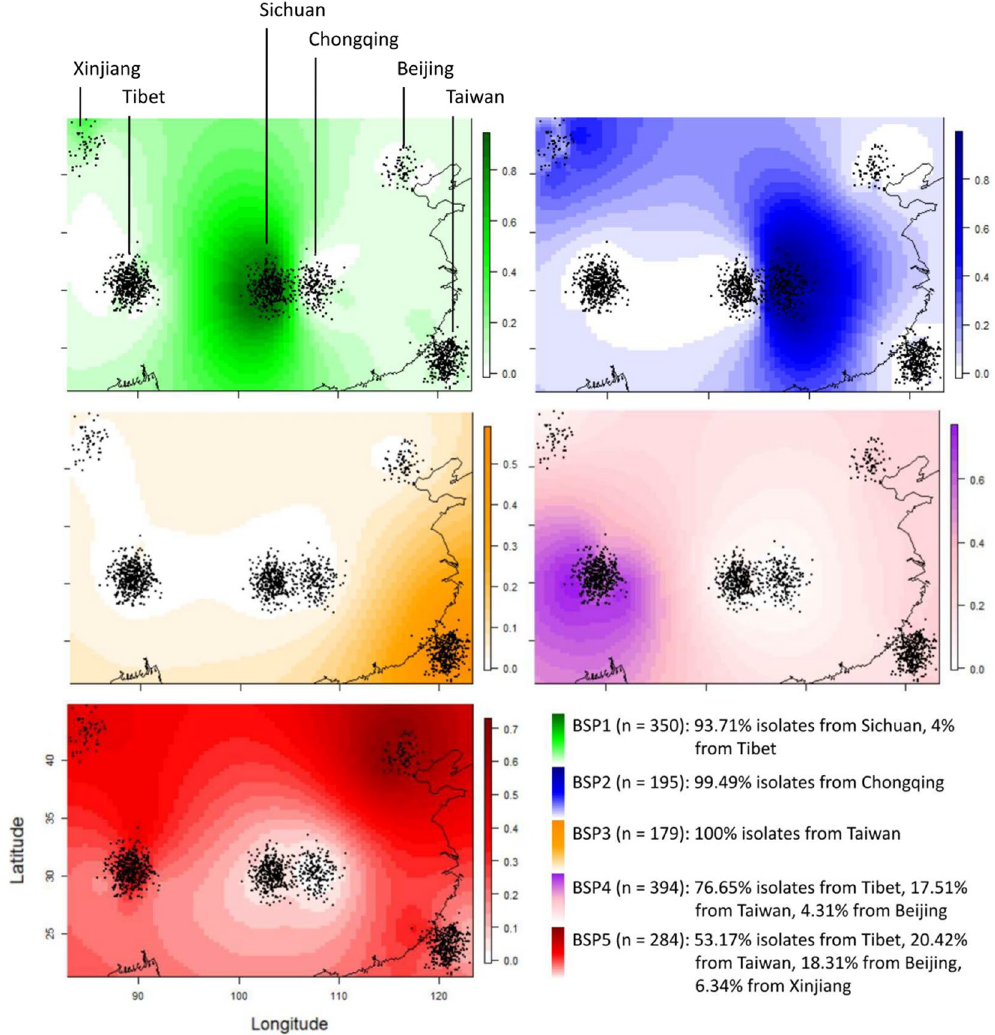
Figure 1. Bayesian population structure analyses based on 24 loci MIRU-VNTRs on 1490 M . tuberculosis Beijing isolates from mainland China and Taiwan. The figure shows STRUCTURE ancestry coefficient (Q-matrix) displayed spatially by universal kriging on separate maps for each K (subpopulation) showing the presence of 5 clonal complexes named BSP1 to BSP5. Briefly, BSP1 and BSP2 were predominant in Sichuan and Chongqing, BSP3 was exclusively found in Taiwan, while BSP4 and BSP5 were present in Tibet, Taiwan, Beijing and Xinjiang; black dots represent spatial coordinates of